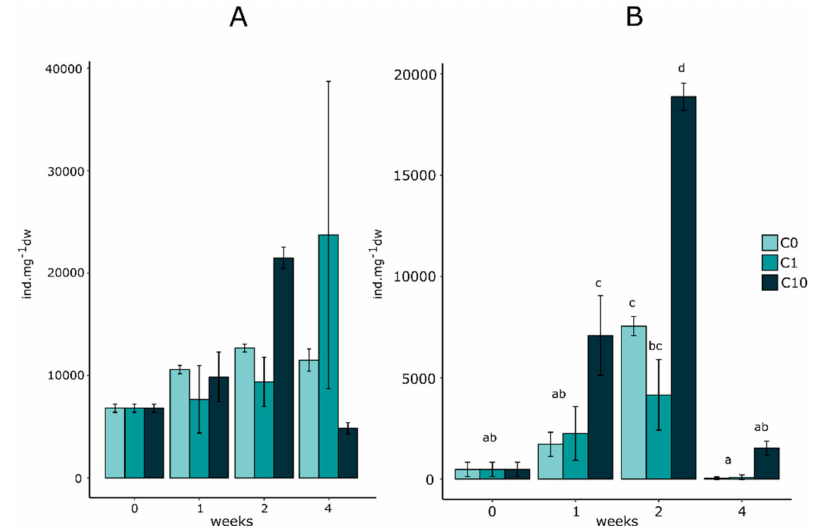
Figure 3. The number of individuals per mg of biofilm dry weight in control C0 = 0.2 ± 0.1 nM) and Zr exposures (C1 = 0.5 ± 0.3 nM and C10 = 2.9 ± 0.3 nM). Values represent means ± standard errors. ( A ) Total micromeiofauna individuals. ( B ) The number of ciliate individuals. A two-way ANOVA was performed to detect significant di ff erences between exposure times ( p < 0.05; n =